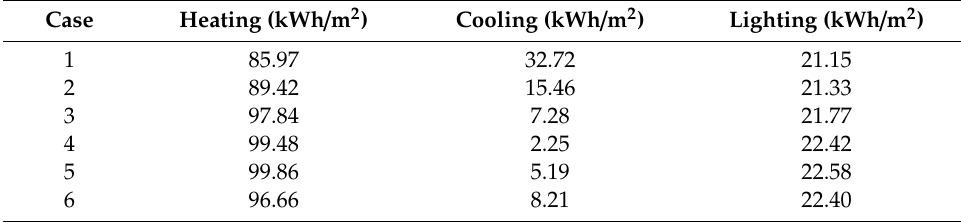
Table 6. Annual energy demands for the different window cases in Stockholm.